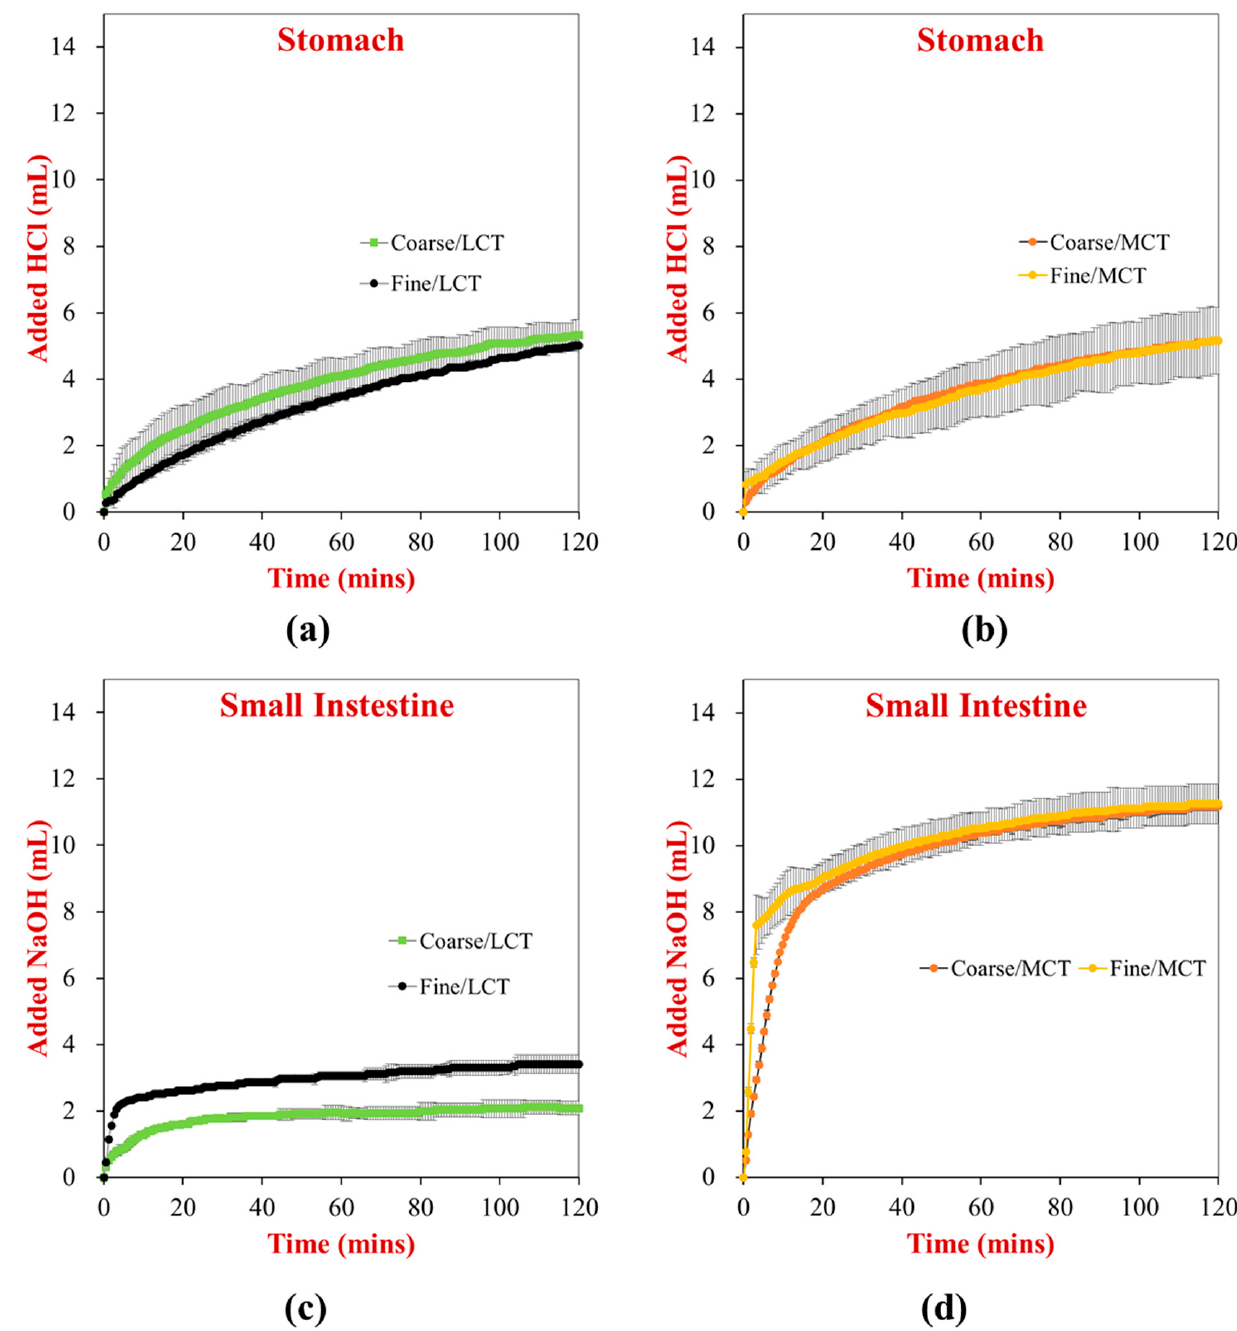
Figure 4. Digestion results obtained in the simulated stomach and small intestine phases using the pH stat method: LCTs in stomach phase ( a ), MCTs in stomach phase ( b ), LCTs in small intestinal phase ( c ), and MCTs in small intestinal phase ( d ). A similar vertical scale was used for all samples to obtain a more direct comparison. LCT: long chain triglycerides. MCT: medium chain triglycer- ides.